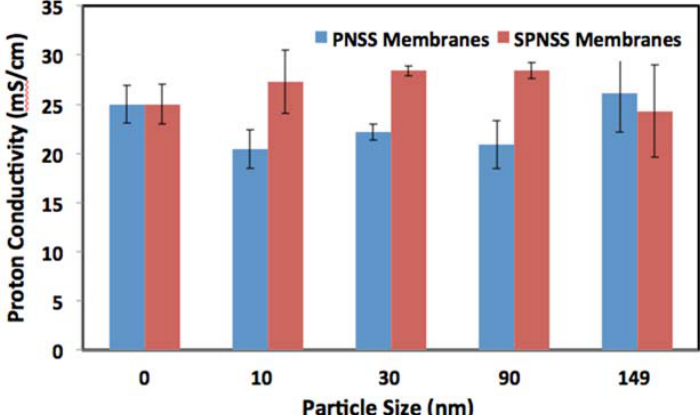
Figure 5. Comparison of the proton conductivity of PNSS and SPNSS nanocomposite membranes at 80 °C and 50% relative humidity.